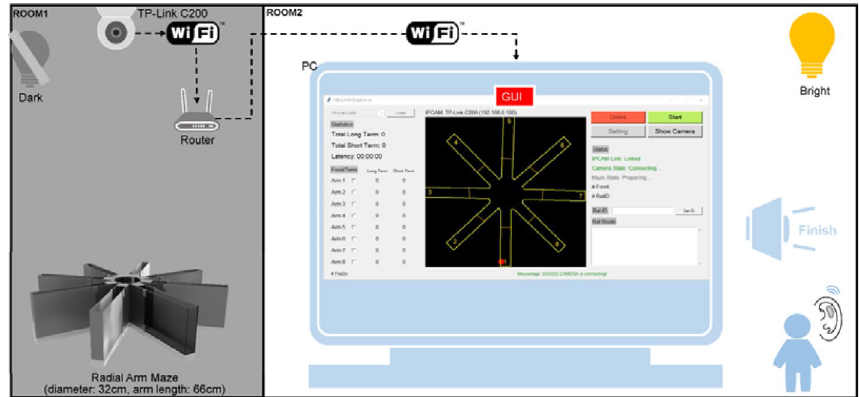
Figure 1. Configuration and framework of the developed system.